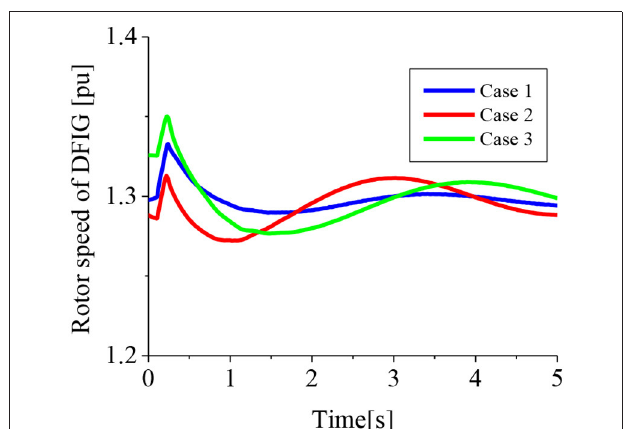
FIGURE 14 | Reactive power of GSC of DFIG (cases